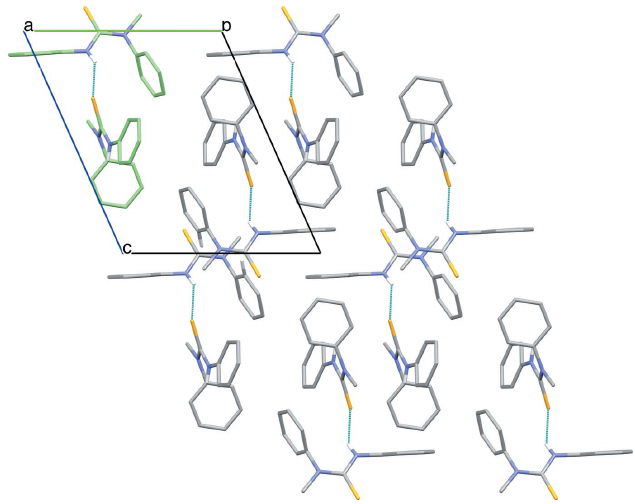
Figure 4 Packing in the structure of 2 , viewed down the a axis, showing the assembly of hydrogen-bonded pairs of molecules, with one pair highlighted (green). Hydrogen atoms (except involved in hydrogen bonds) are omitted for